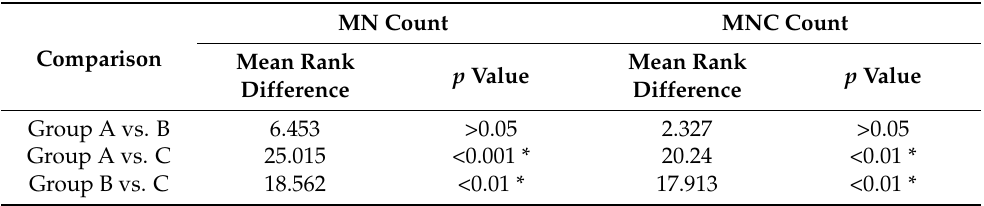
Table 3. Results of the Dunn’s multiple comparison